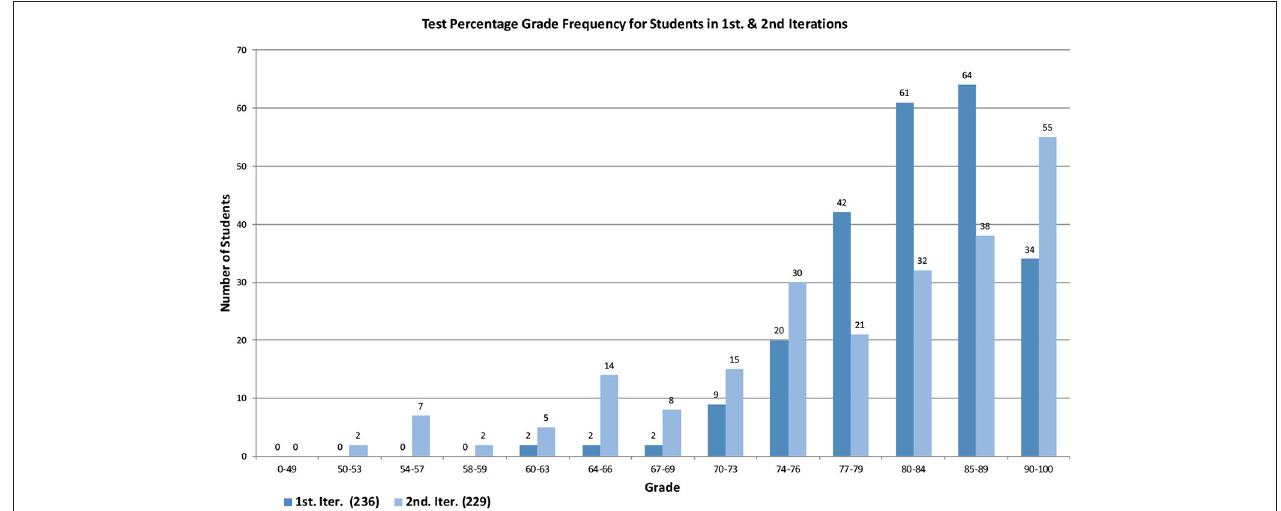
FIGURE 5 | Grade frequency for test. 236 and 229 students took the test during the 1st and 2nd iterations,